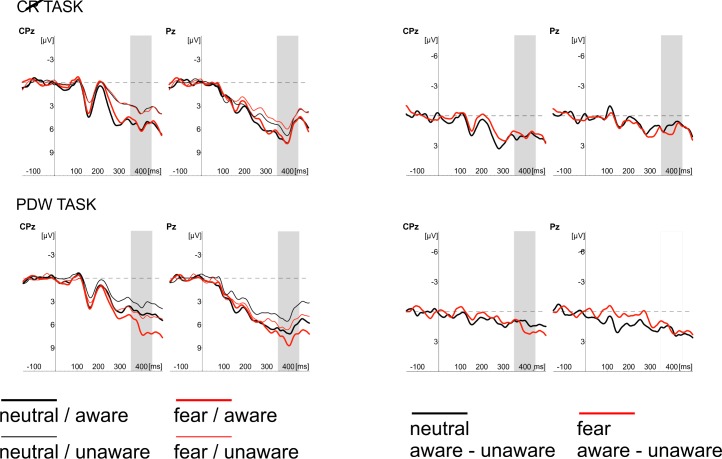
Grand average of ERPs recorded in CR and PDW tasks at parietal electrodes (CPz, Pz) in response to neutral (black lines) and fearful faces (red lines)–left panel.Responses obtained in “unaware” (thin lines) and “aware” trails (thick lines) are also shown. The right panel shows difference waves computed as a difference between aware and unaware conditions recorded in CR and PDW tasks at parietal electrodes (CPz, Pz) in response to neutral (black lines) and fearful faces (red lines). Time windows for the region of interest (P3 component; 300–400 ms post-stimulus) are highlighted at corresponding electrodes; time 0 indicates stimulus onset.